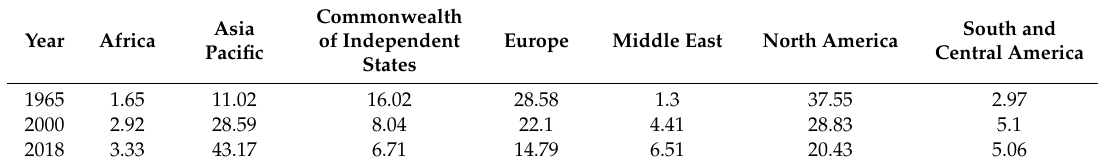
Figure 3. Historical global electricity consumption by region [18]. Table 1. Percentage of global electricity consumption by region [18].